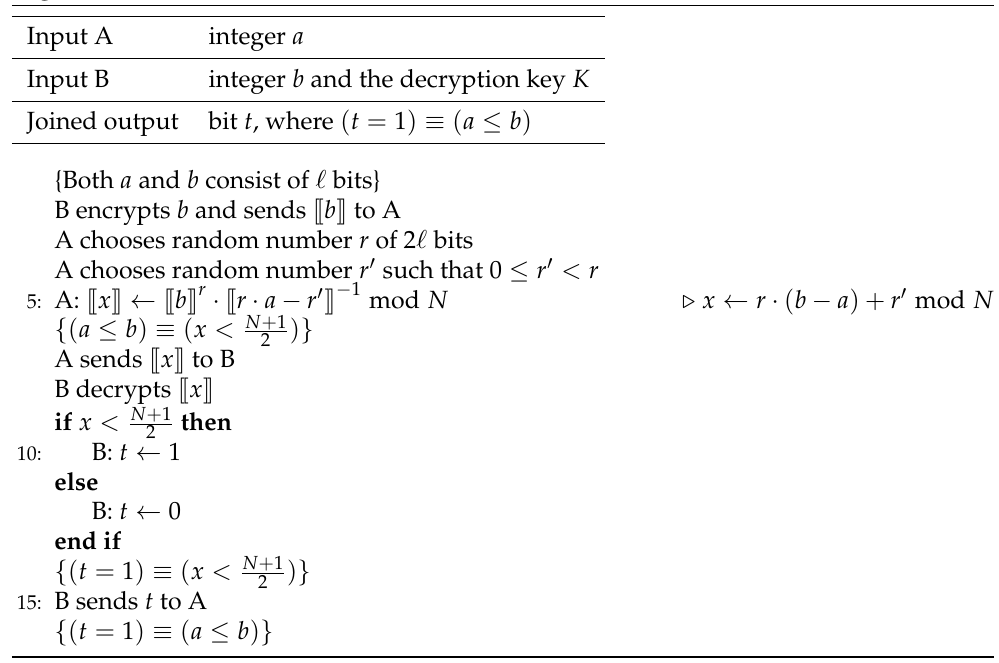
Algorithm 2 Kerschbaum and Terzidis (KT).